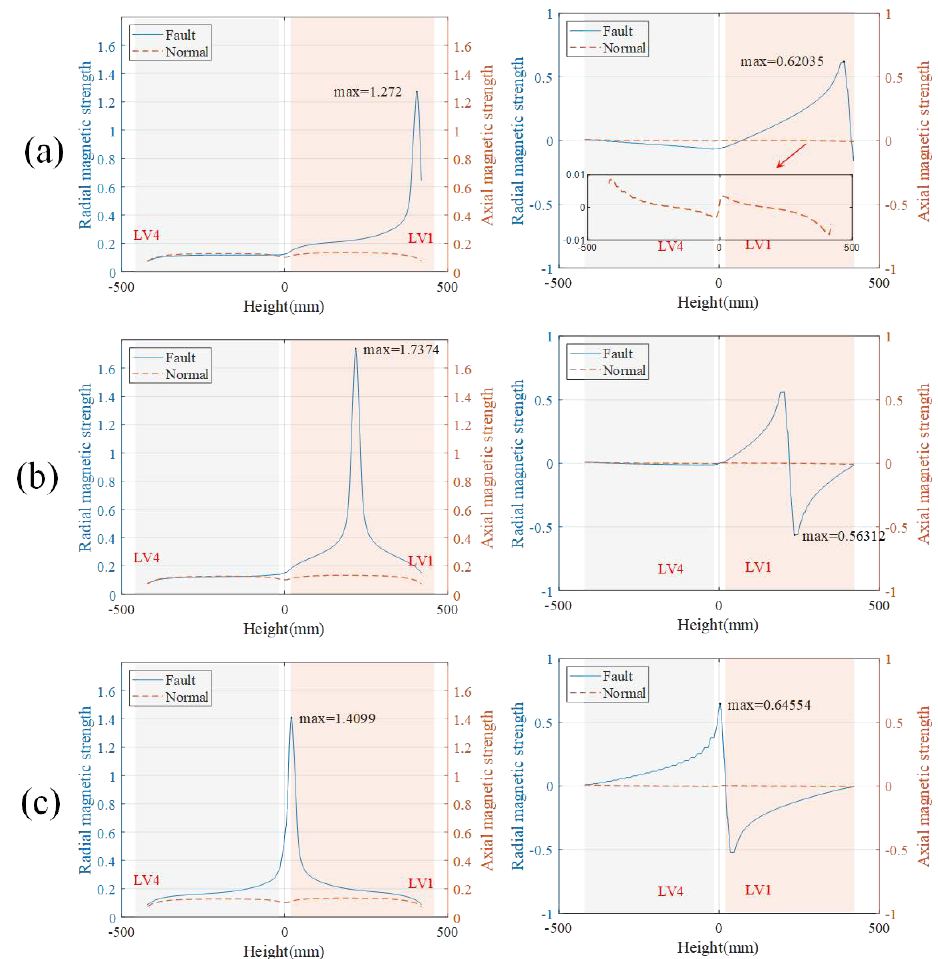
Figure 4. The distribution of radial and axial magnetic flux leakage under the TTFs at 59 ms. ( a ) Top turn-to-turn fault. ( b ) Middle turn-to-turn fault. ( c ) Bottom turn-to-turn